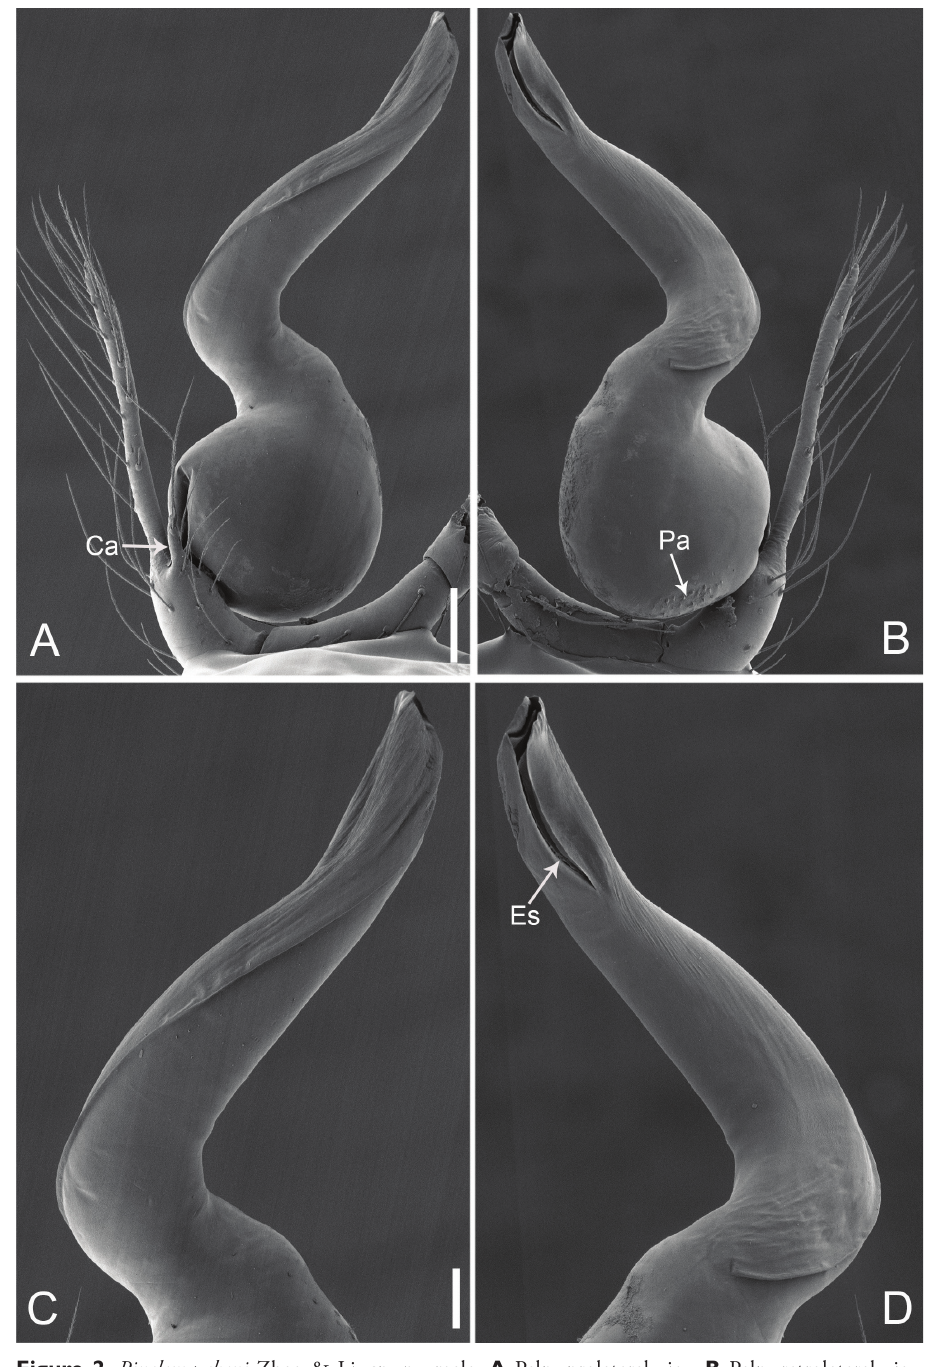
Figure 2. Pinelema cheni Zhao & Li, sp. n., male. A Palp, prolateral view B Palp, retrolateral view C Embolus, prolateral view D Embolus, retrolateral view. Scale bars: 0.1 mm ( A–B ), 0.05 mm ( C–D